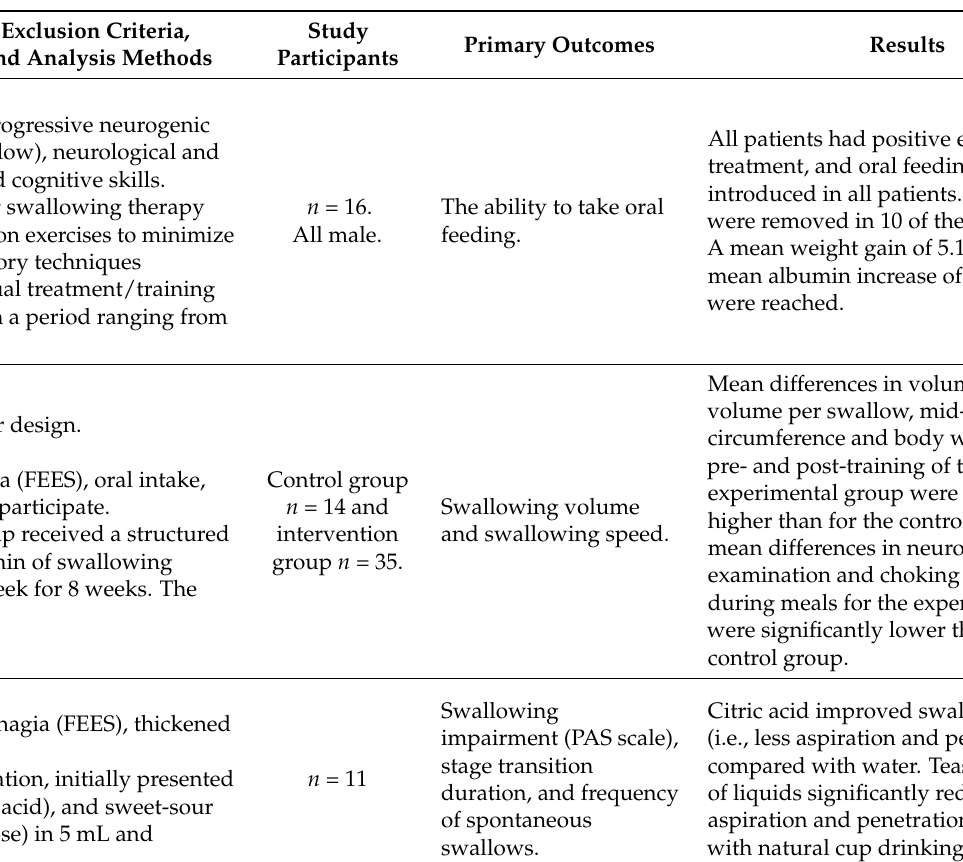
Table 1. Summary of study details and population (sorted after publication